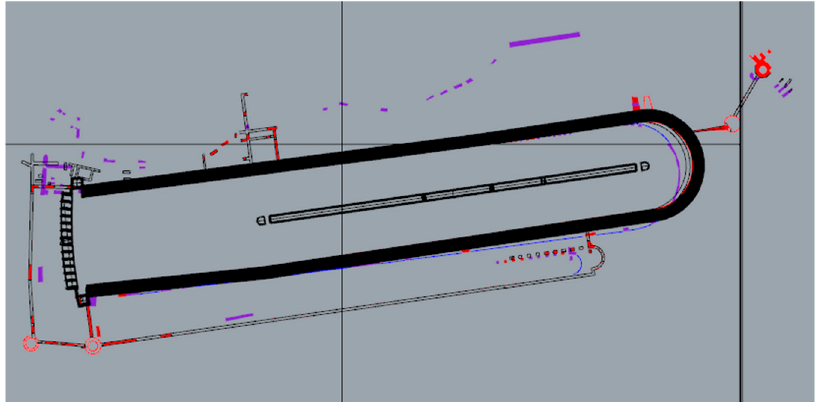
Figure 11. The reconstruction of the circus starting from the documentation provided from the past studies reported on different layers of the same GIS.